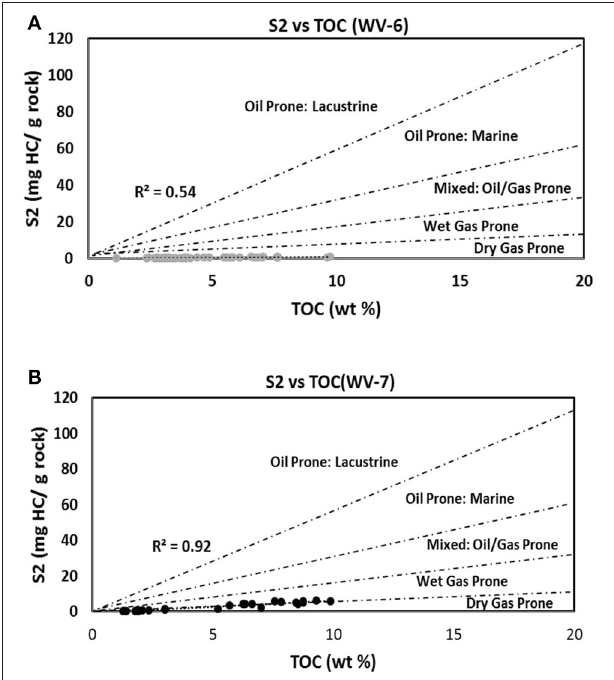
FIGURE 7 | The S2 vs. TOC plots for (A) WV-6 and (B) WV-7 samples.